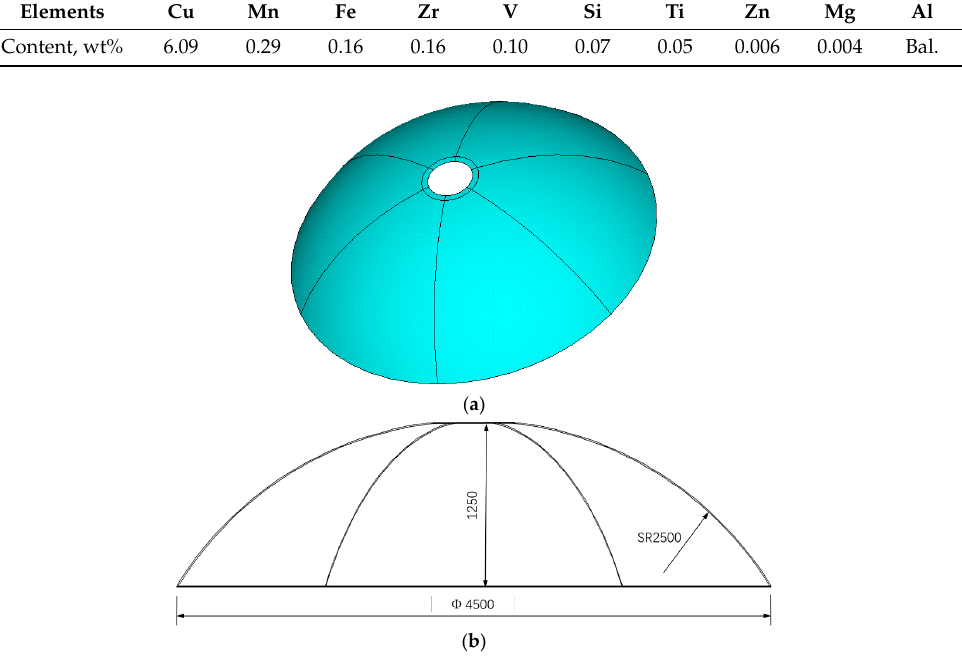
Figure 2. Two typical welding positions studied.